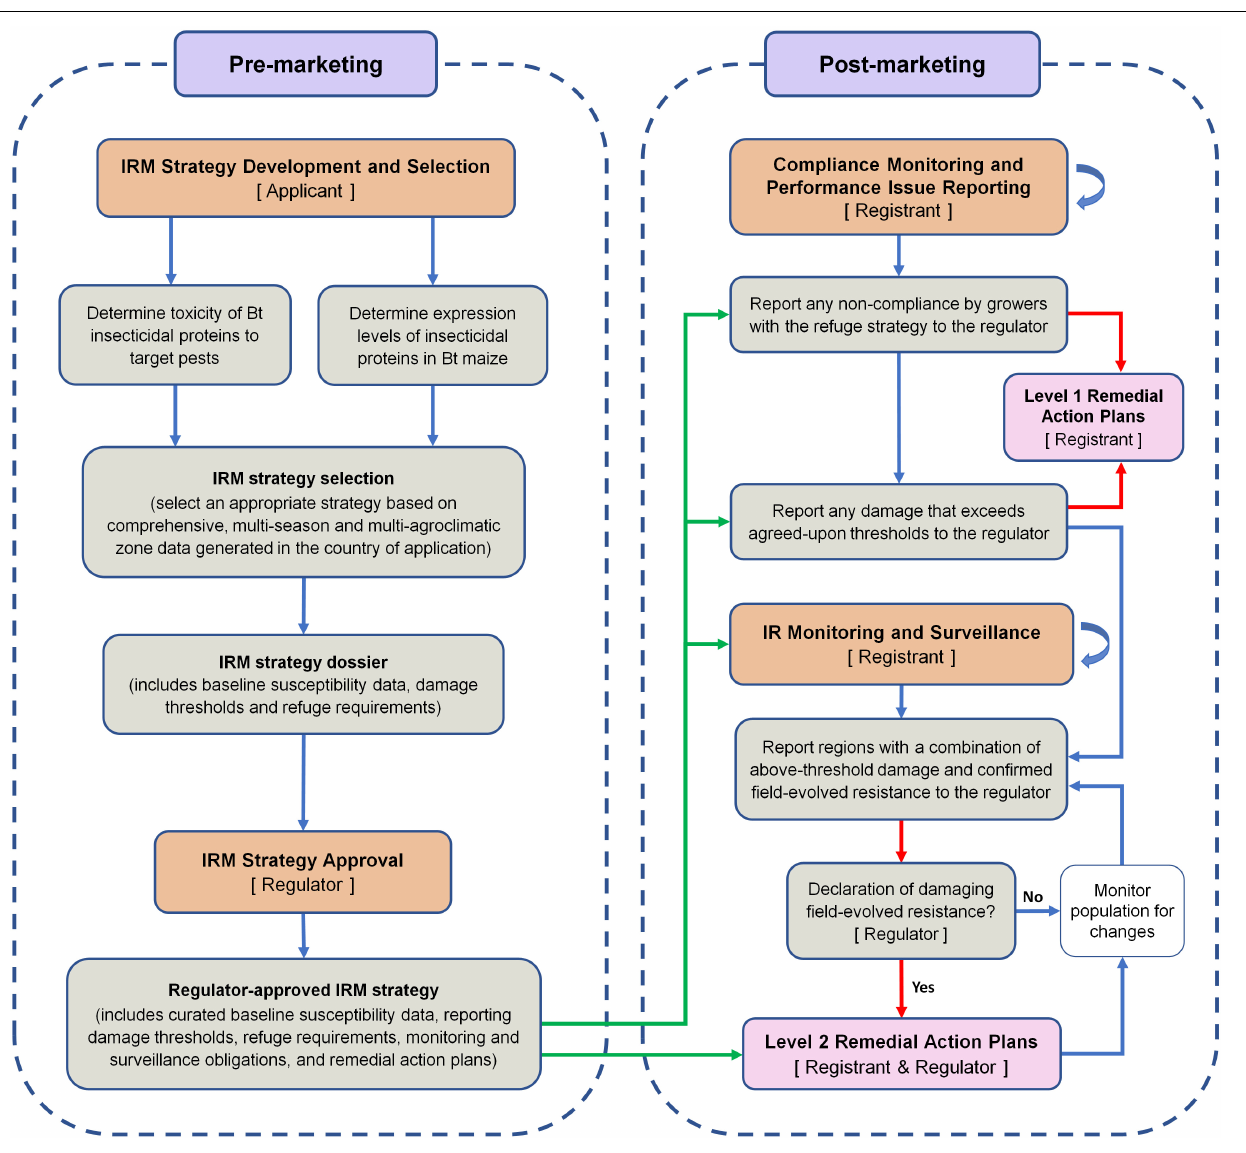
FIGURE 2 | A framework for the implementation of an effective pest- and event-specific Bt maize insect resistance management program. The stakeholders responsible for key steps are shown in square brackets. The core of the framework is the regulator-approved IRM strategy dossier. Arrows: green arrows show post-marketing activities that are guided by the regulator-approved IRM strategy; red arrows show the pathways that lead to the implementation of remedial action plans; blue curved arrows show that a process continues throughout the post-marketing phase. For the sake of simplicity, it is assumed that the applicant is also the technology developer/provider. Once approval has been granted for commercial cultivation, the applicant becomes the registrant.